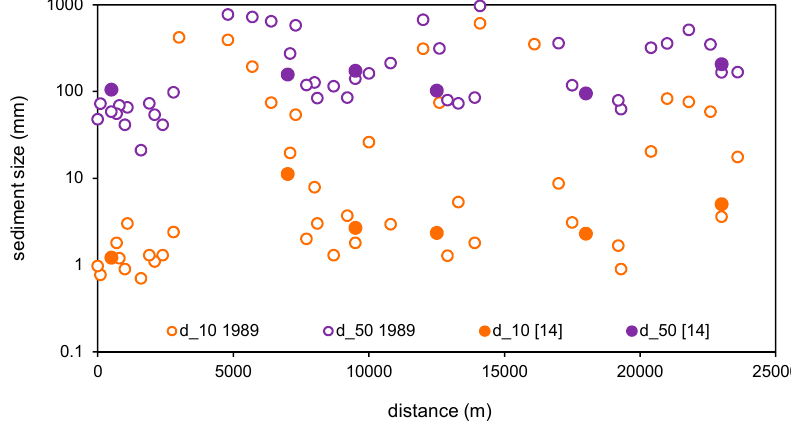
Figure 3. Sediment size along the river course according to a survey by Techint in 1989 and [14], d _p indicating the size corresponding to p percent in the granulometric distribution.